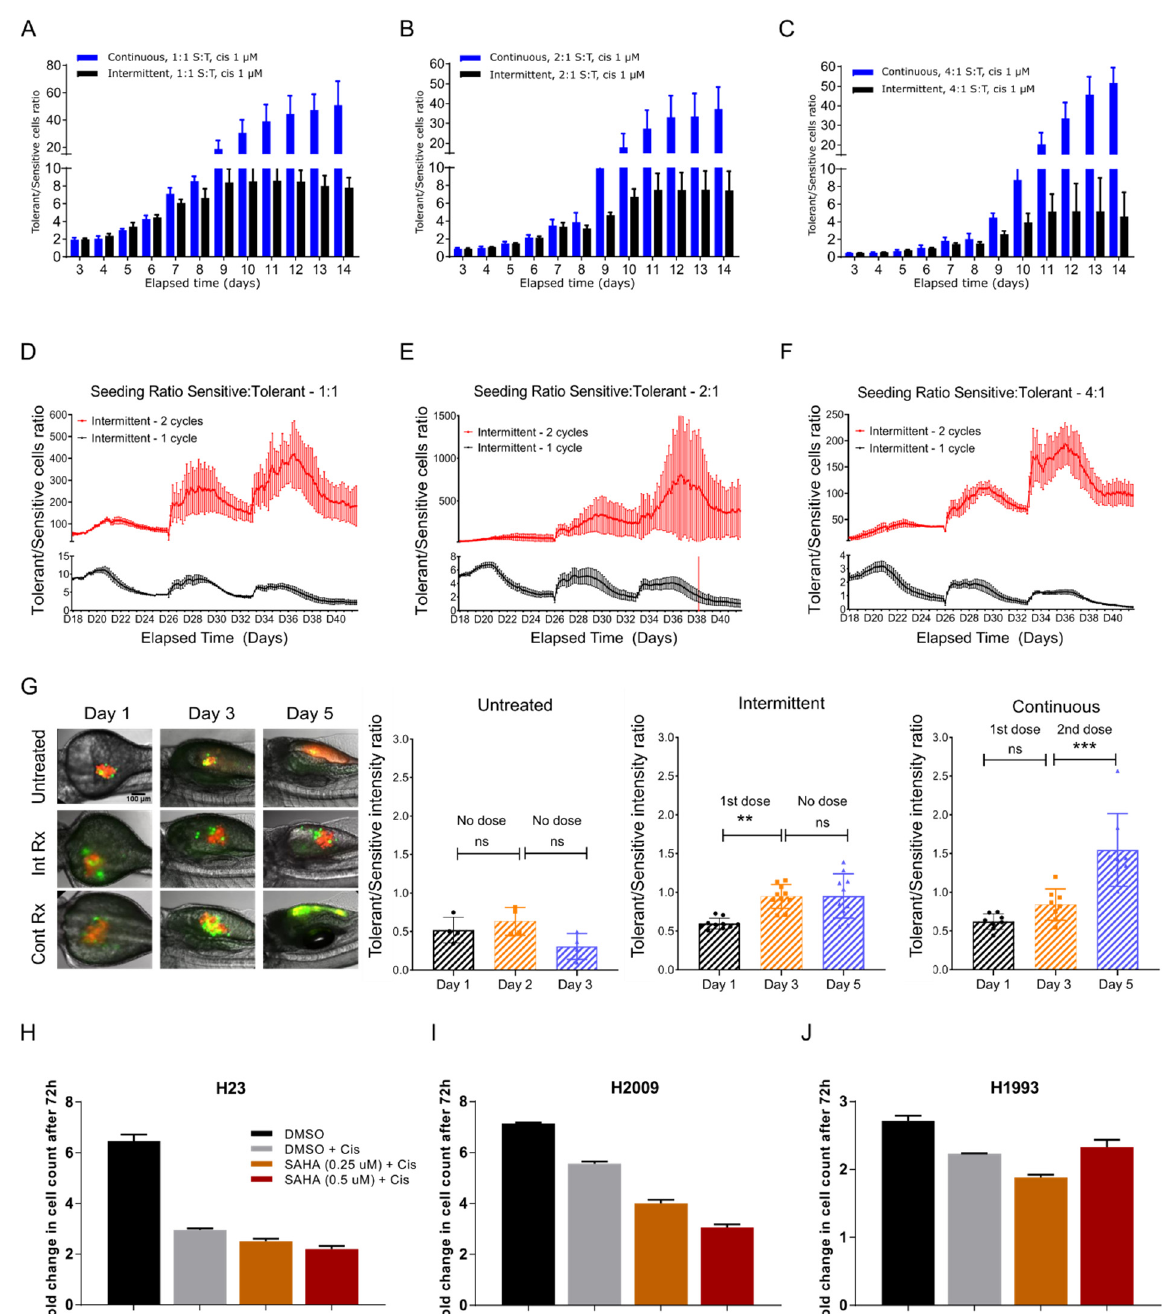
Figure 3. Tolerant cells reversibly switch their phenotype to become sensitive with intermittent therapy. ( A – C ) Bar graph showing the ratio of tolerant versus sensitive cell population over a period of 10 days. The cell ratio for the “Continuous” group wherein the cells were continuously treated with cisplatin is shown in blue and the ratio for the “Intermittent” group wherein the cells were treated with cisplatin for two days and released in fresh medium (intermittent) is shown in black. ( D – F ) Media from “Intermittent—2 cycles” group was removed after four days of cisplatin treatment and replaced with fresh medium and the cells were allowed to grow until confluent. These cells were monitored in real-time to determine the ratio of tolerant versus sensitive over the course of 25 days. Similarly, the cells that only received cisplatin once (“Intermittent—1 cycle”) throughout the experiment were also followed for 25 days. ( G ) Sensitive (S, red fluorescence) and tolerant (T, green fluorescence) cells were mixed at S:T ratio of 4:1 and microinjected into the perivitelline space of zebrafish larvae 48-h post fertilization (hpf). Twenty-four hours after microinjection, larvae were randomly divided into three groups: Group 1 received no drug treatment (Untreated), Group 2 re- ceived cisplatin 20 µM for three days and released with no drug for two days (Intermittent), and